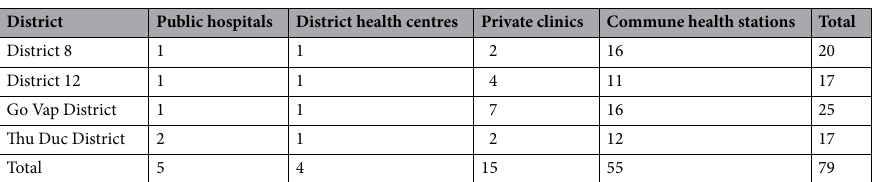
Table 1. Facilities where staff were trained by Communities for Healthy Hearts to provide standardised hypertension services.